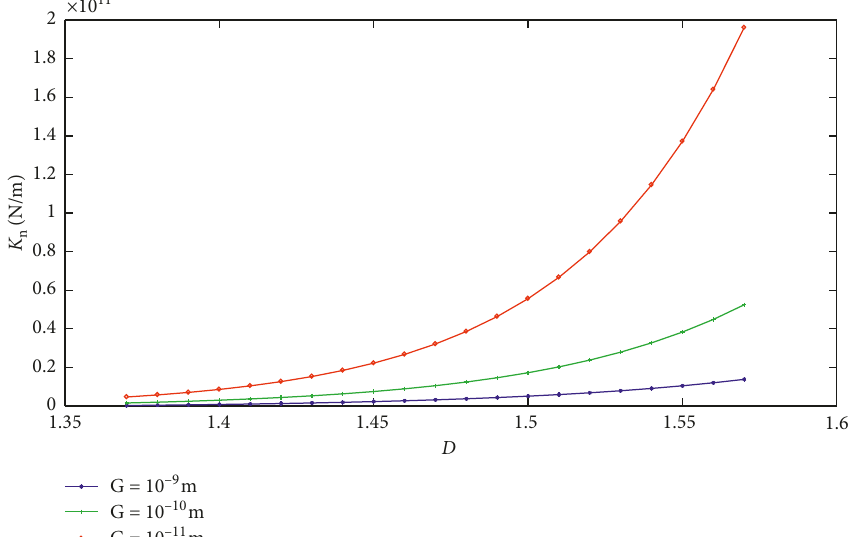
Figure 5: Variation of contact stiffness K